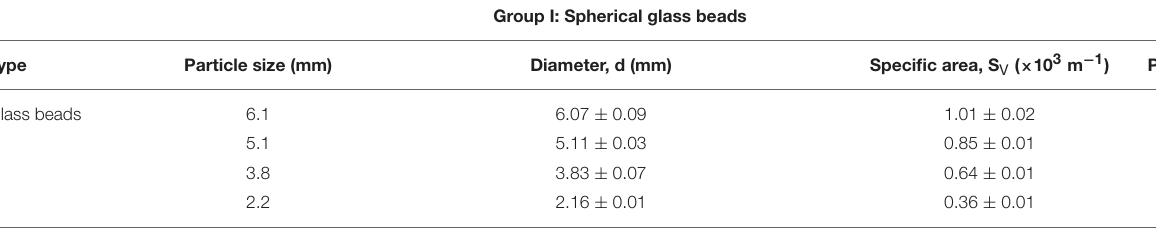
TABLE 1 | Particles physical properties.